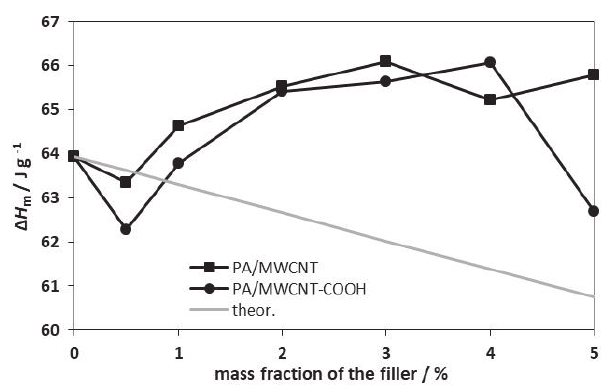
Fig. 5 – Melting enthalpy of PA/MWCNT and PA/MWCNT- COOH